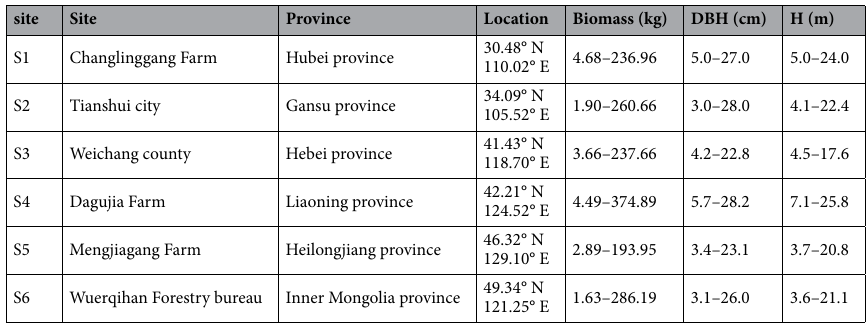
Table 1. The basic features of the sampling